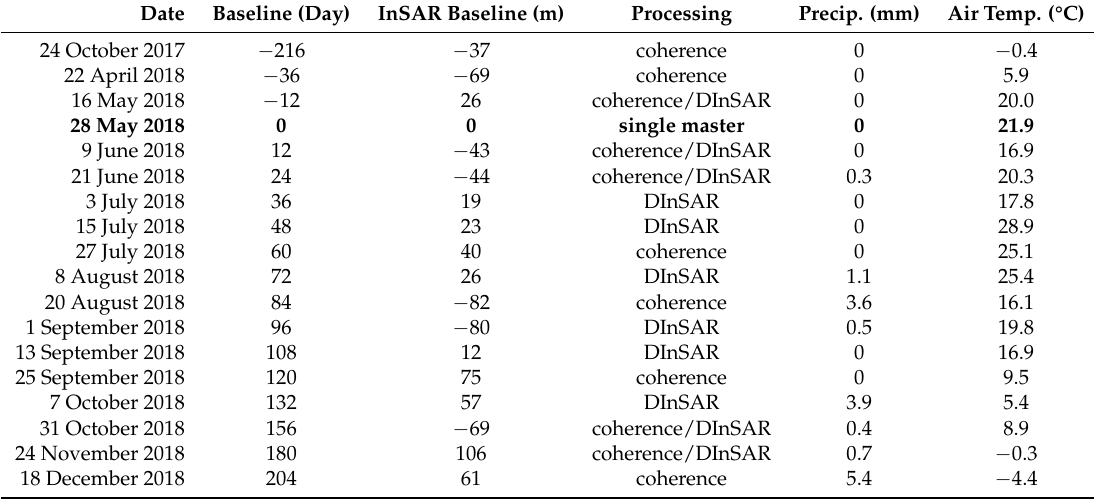
Table 1. Sentinel-1 Interferometric Wide swath mode (IW) Single Look Complex (SLC) acquisitions used in this study and corresponding weather data (sum of daily precipitation (mm) and air temperature (°C) at 6 p.m. local time, all acquisitions obtained in ascending geometry, relative orbit number 160. Temporal and InSAR baseline are given relative to the single master image of 28 May 2018 (shown in bold) used in processing (either in coherence magnitude or DInSAR displacement